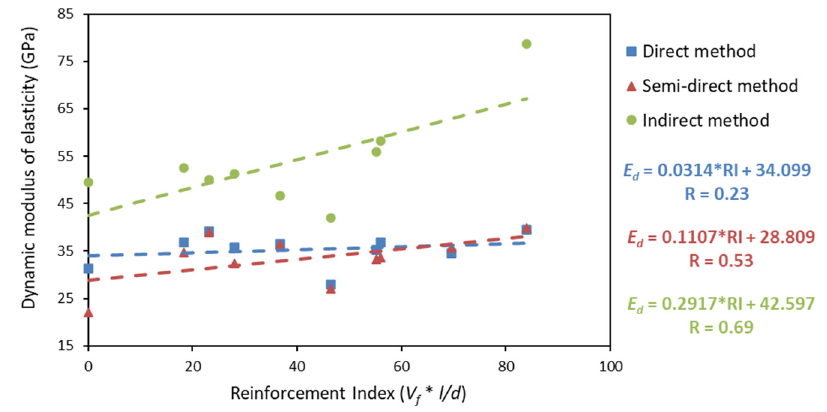
Figure 13. Correlation between the reinforcement index and the dynamic elasticity modulus.